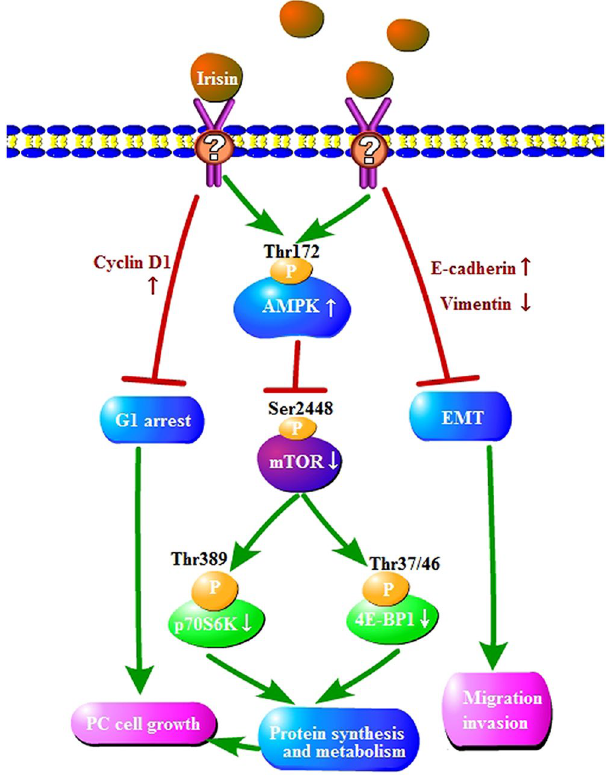
Figure 5. Proposed model of irisin effects on pancreatic cancer. AMPK: adenosine monophosphate-activated protein kinase, P: phosphorylation sites, EMT: epithelial- mesenchymal transition, p70S6 kinase: ribosomal protein S6 kinase, 4E-BP1: eukaryotic translation initiation factor 4E binding protein 1, PC: pancreatic